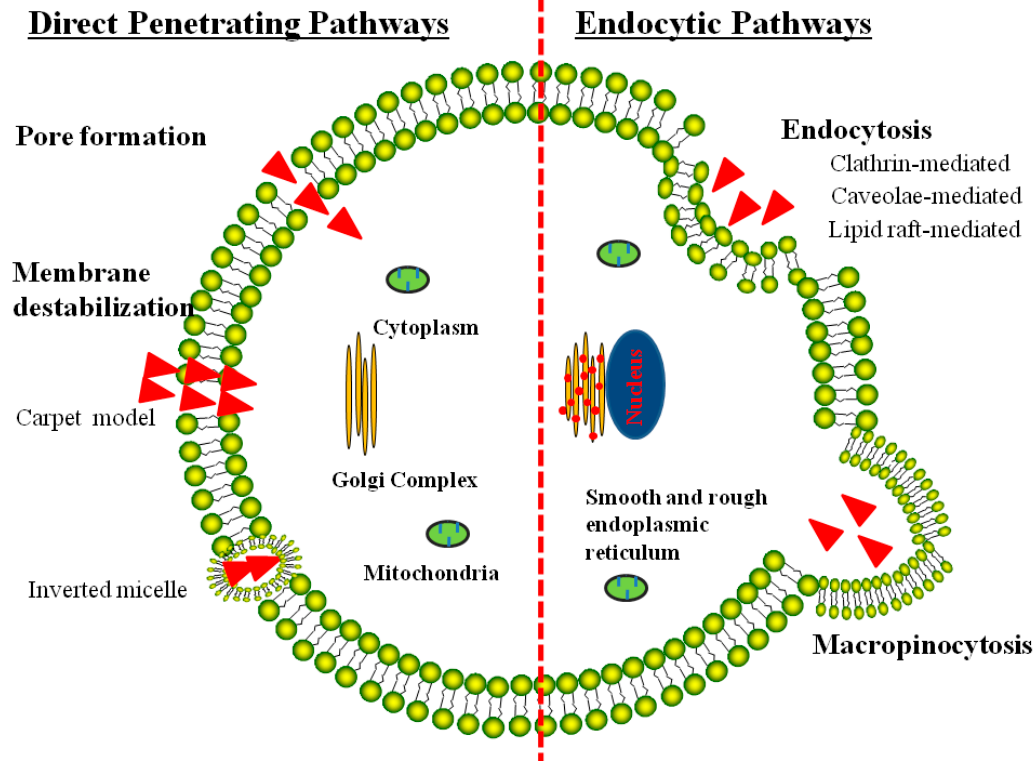
Figure 2. Mechanisms reported for the CPP-mediated intracellular drug delivery strategy.